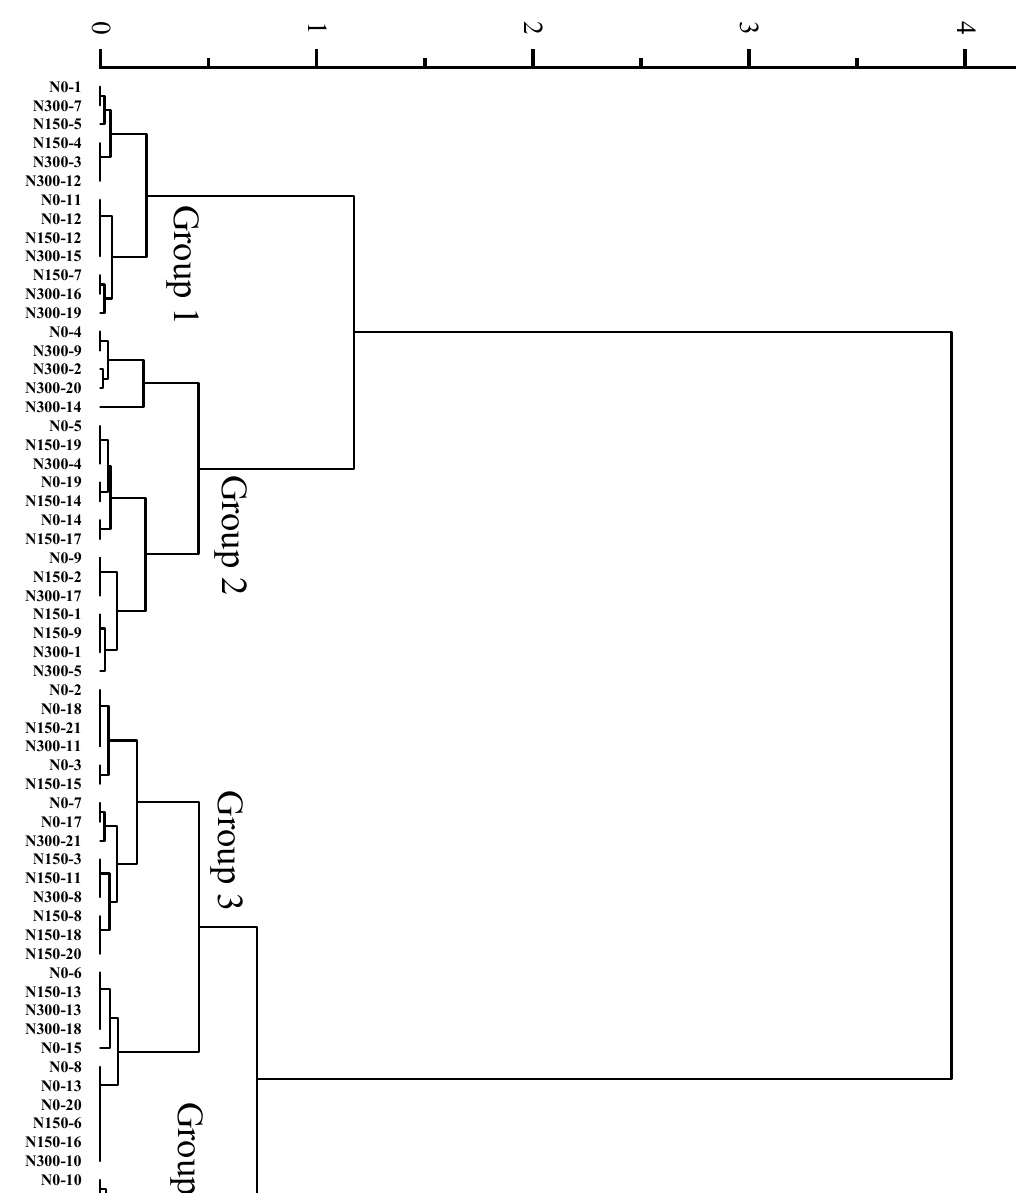
Figure 5. Cluster analysis of D values of various hybrid indica rice varieties under different nitrogen fertilizer conditions. Group 1 refers to the highest D value type, followed by Groups 2, 3, and 4.